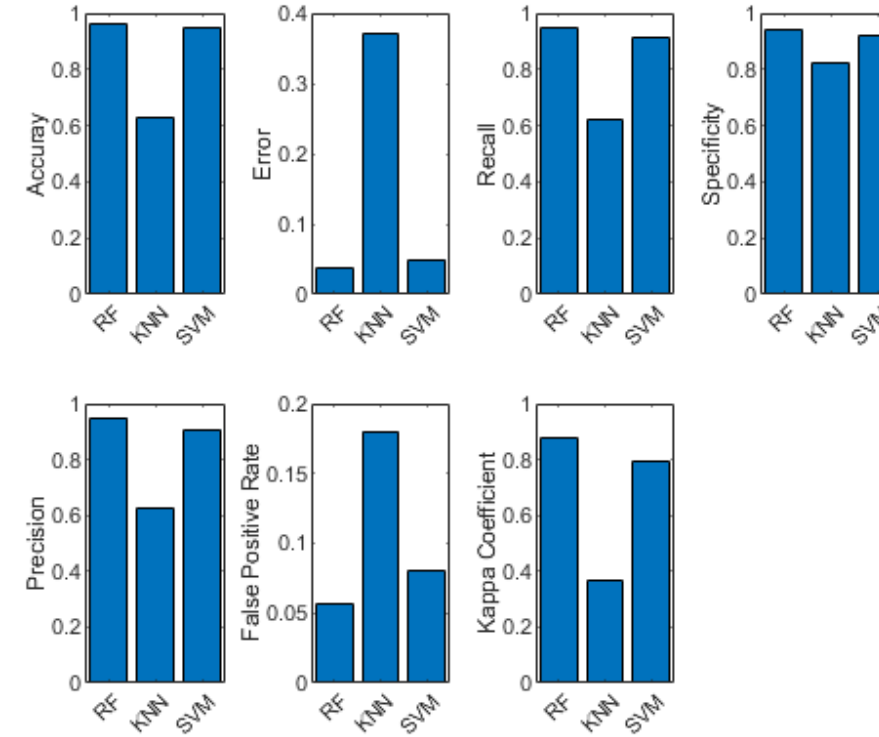
Figure 5. Comparison of performance matrices for RF, KNN and